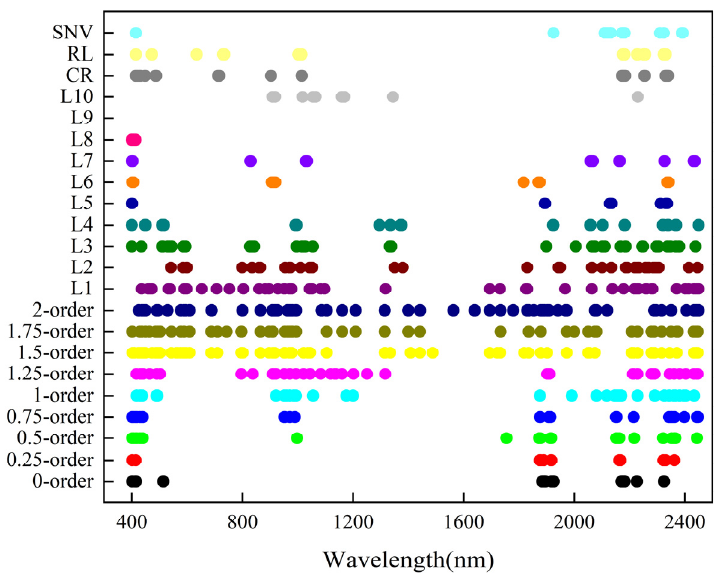
Figure 9. Diagram of the selection of characteristic wavelengths for different spectral transfor- mations.